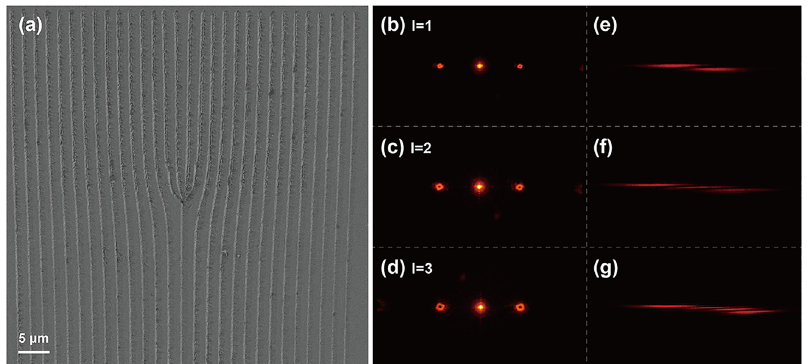
Figure 4: (a) SEM image of the l = 3 fork grating fabricated by LWISCE. (b) – (d) are the ± 1-order diffraction patterns from l = 1, 2, and 3 fork-gratings. (e) – (g) are the transformed patterns after a cylindrical lens,inwhichthe l valuecanbeobtainedby counting the number of dark